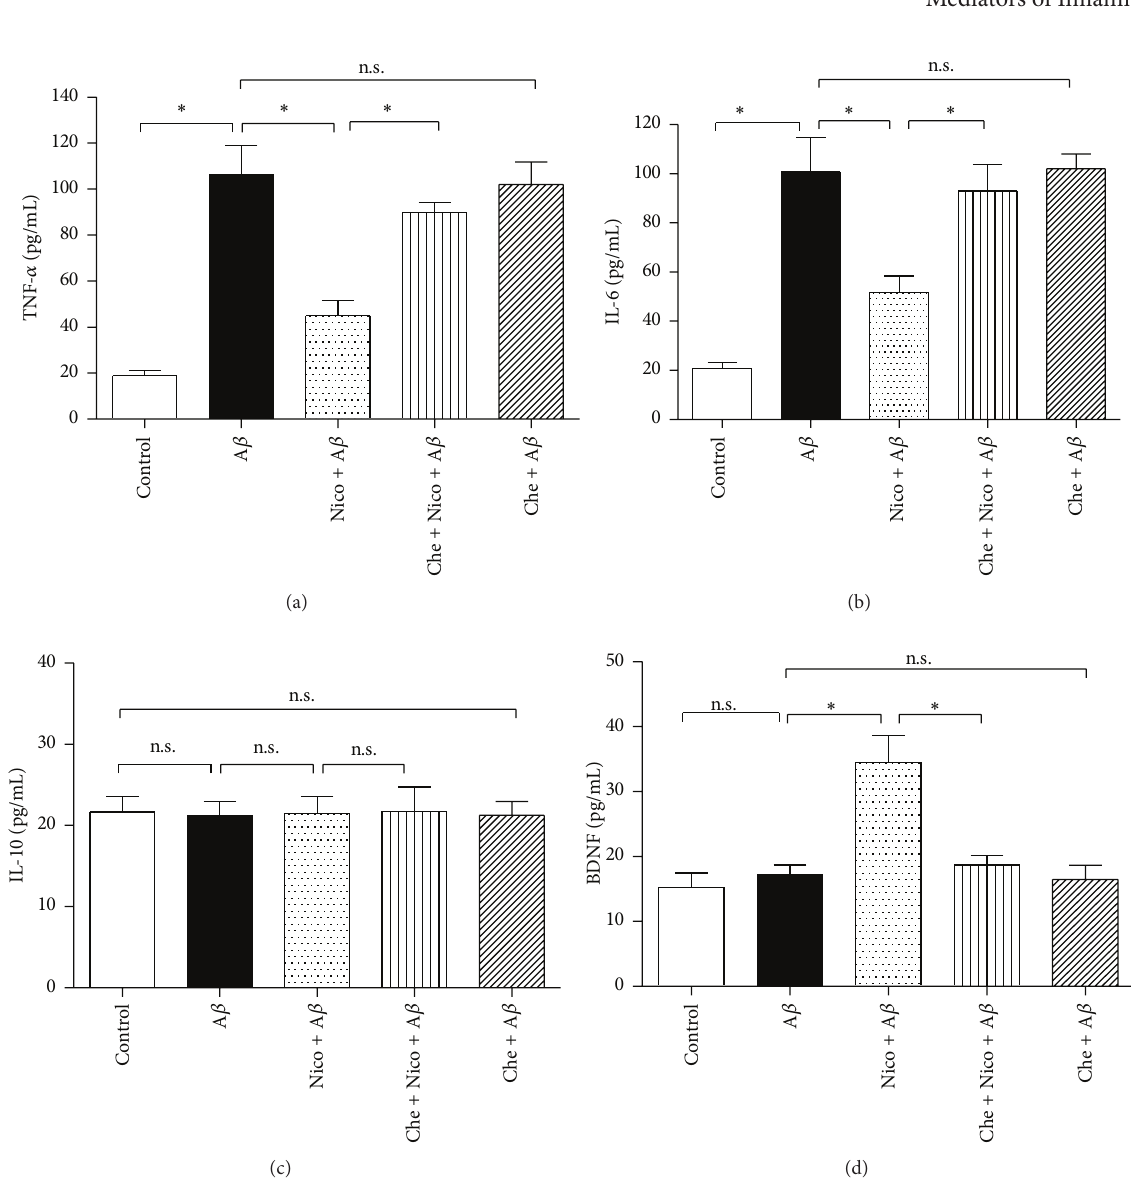
Figure 6: PKC inhibitor reversed nicotine-induced effects on TNF- 𝛼 , IL-6, and BDNF releases. The microglial cells were divided into five groups:control:cellsculturedindrug-freemedium;A 𝛽 :cellsculturedinthemediumcontaining5 𝜇 MA 𝛽 ;nicotine(Nico)+A 𝛽 :cellscultured in the medium containing 10 𝜇 M nicotine and 5 𝜇 M A 𝛽 ; Che + Nico + A 𝛽 : cells cultured in the medium containing 10 𝜇 M PKC inhibitor chelerythrine (Che), 10 𝜇 M nicotine, and 5 𝜇 M A 𝛽 ; Che + A 𝛽 : cells cultured in the medium containing 10 𝜇 M chelerythrine and 5 𝜇 M A 𝛽 . After an incubation of 24 h, concentrations of TNF- 𝛼 (a), IL-6 (b), IL-10 (c), and BDNF (d) were assessed by using the corresponding reagent kit ( 𝑛 = 6 ). Results are expressed as means ± SD, ∗ 𝑃 < 0.05 ; n.s.: no